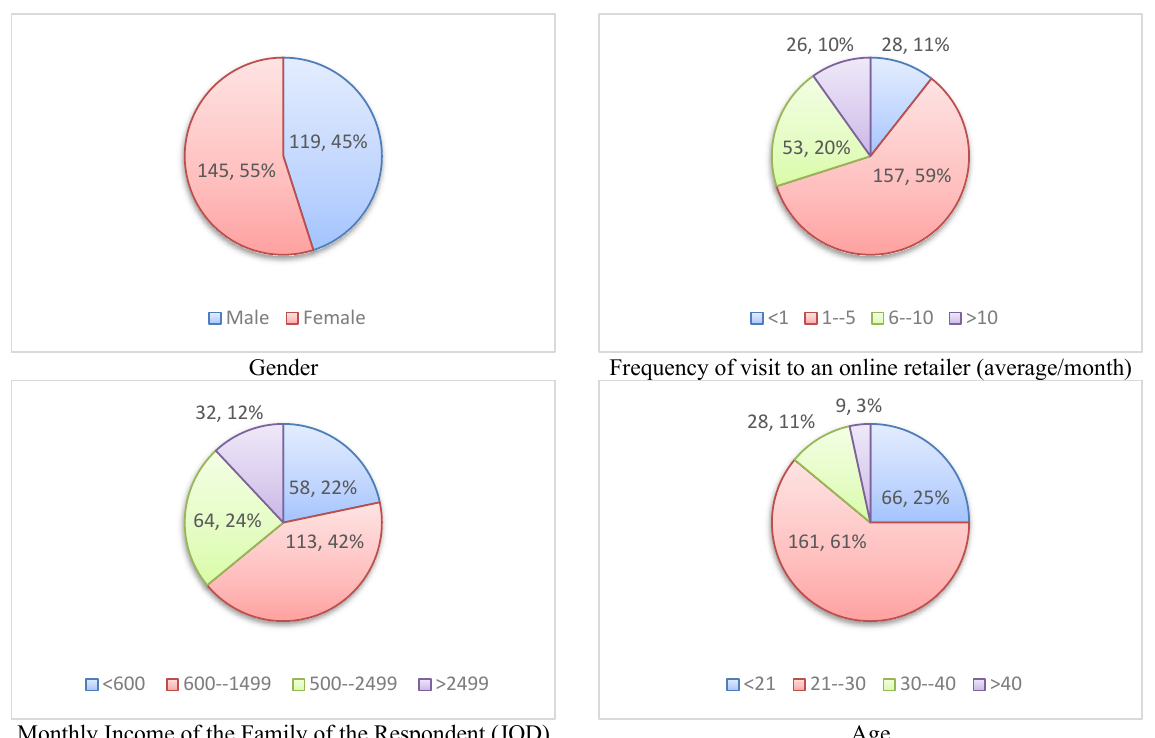
Fig. 2. Personal characteristics of the